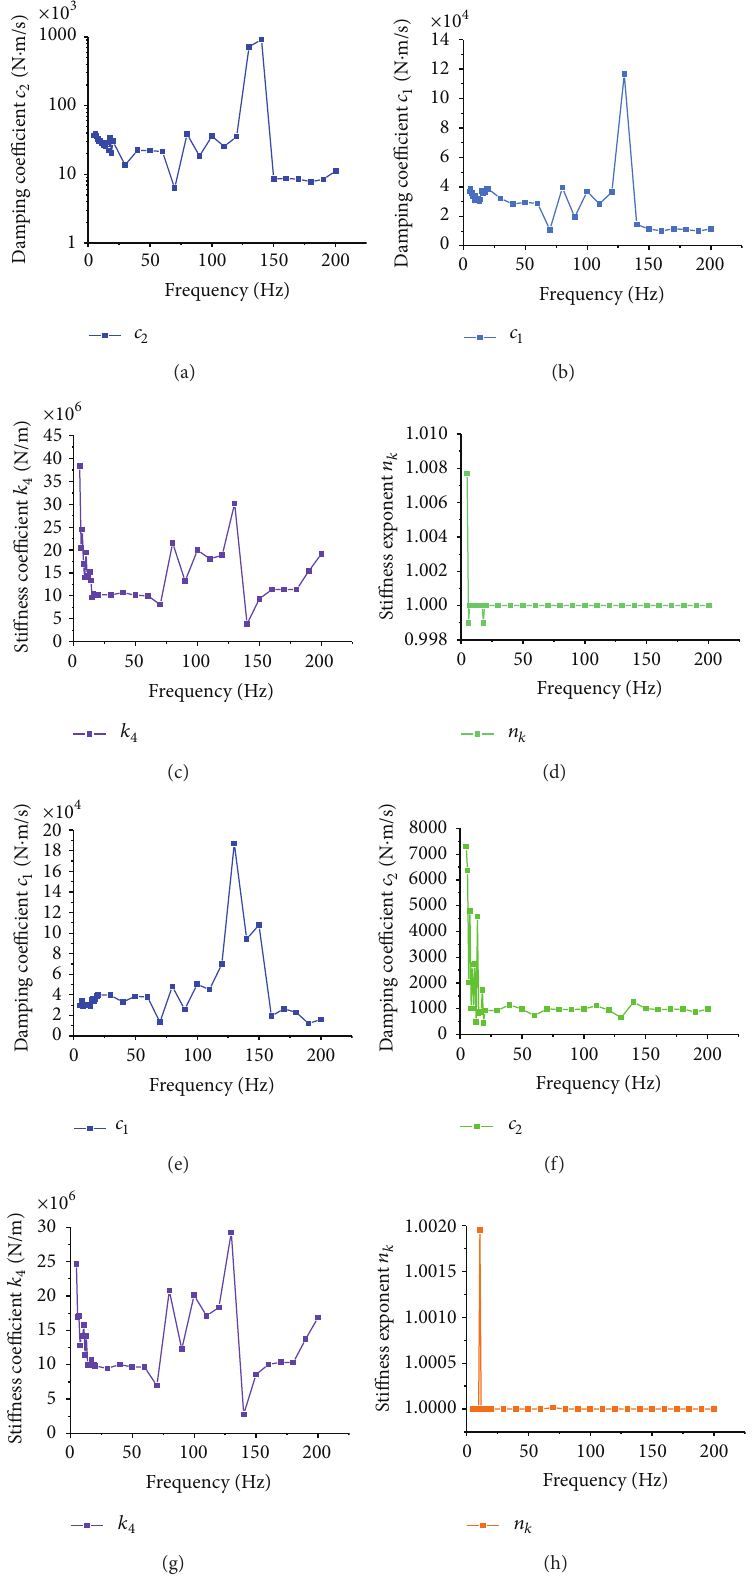
Figure 8: Variations of vibration model parameters with excitation frequency. (a) Simple model; (b), (c), and (d) GNM; (e), (f), (g), and (h)